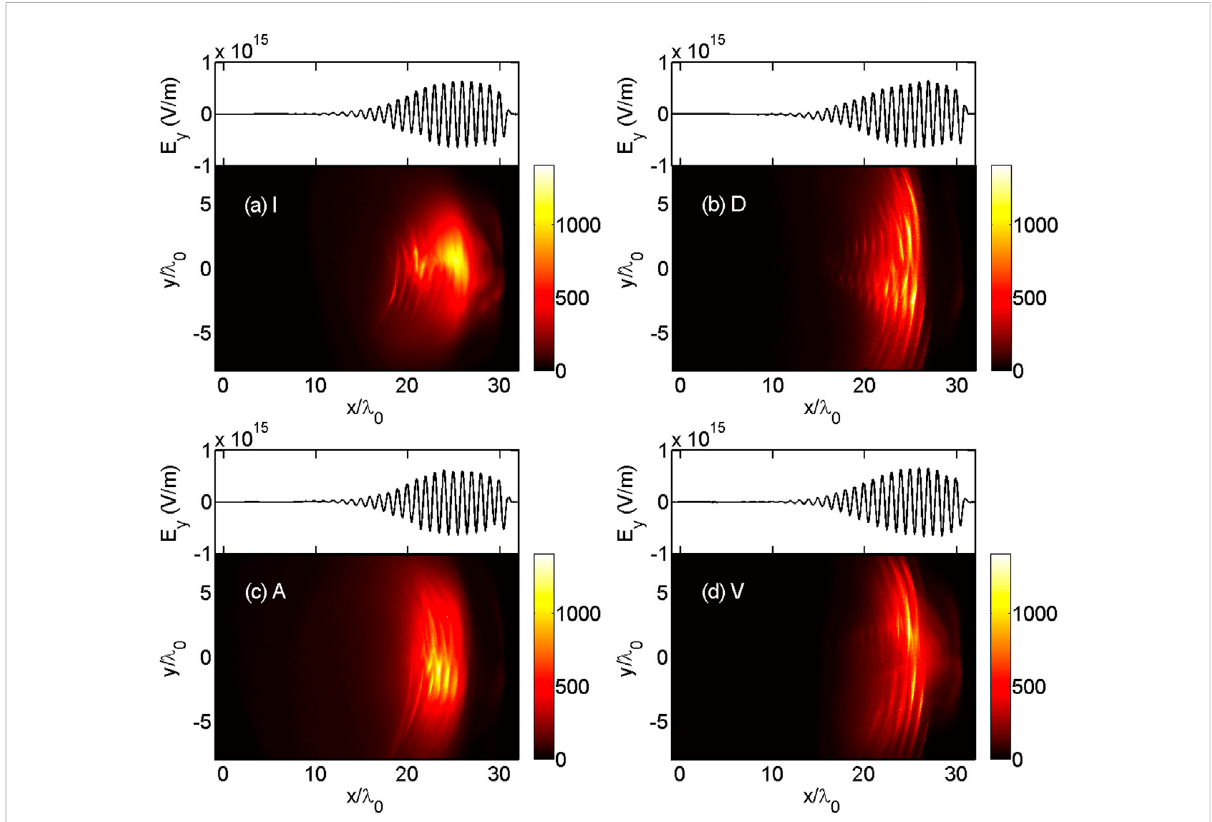
FIGURE 3 Energy density ( MeV · n c ) distributions of radiated photons at t (cid:2) 35T 0 in simulations with different types of plasmas and the pro fi le of the transverse electric fi eld E y (V/m) at t (cid:2) 35T 0 in each